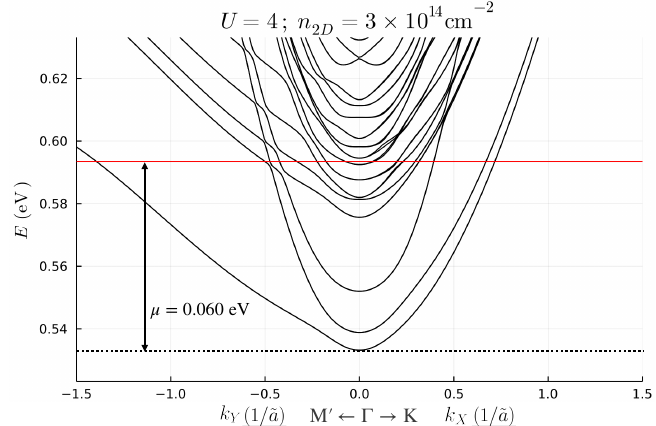
Figure 5. Low filling electronic band structure in the presence of Coulomb interactions for the